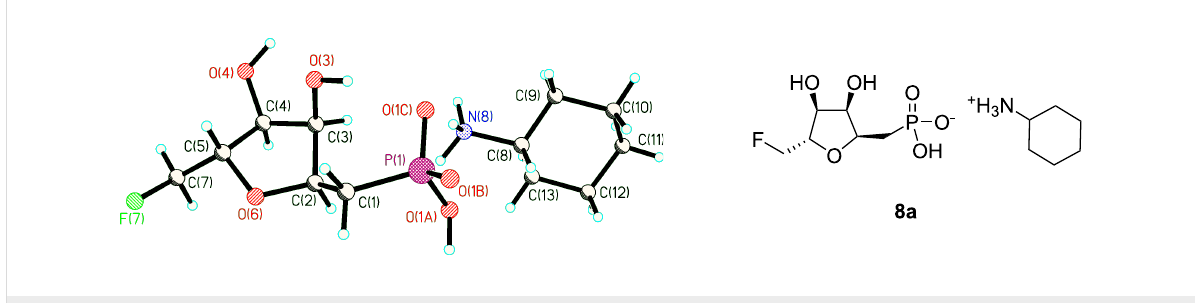
Figure 2: X-Ray crystal structure of cyclohexylammonium salt 8a .